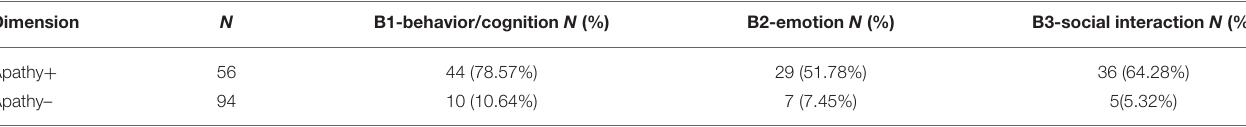
TABLE 2 | Presence of CSVD aged patients in each apathetic dimension according to DCA.